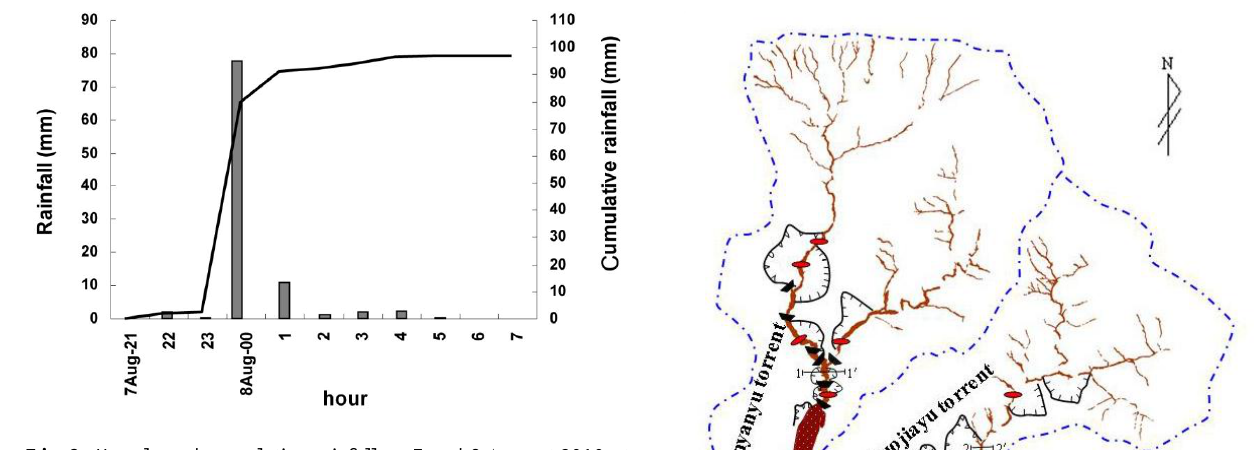
Fig. 2. Hourly and cumulative rainfall on 7 and 8 August 2010 at Dongshan rain-gage station. 3